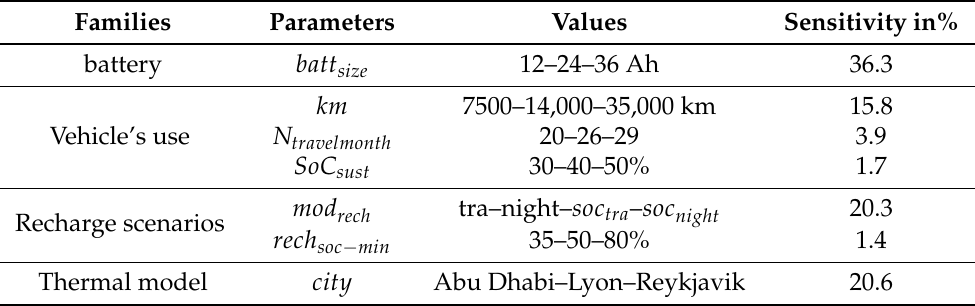
Table 5. Sensitivity value for selected parameters.